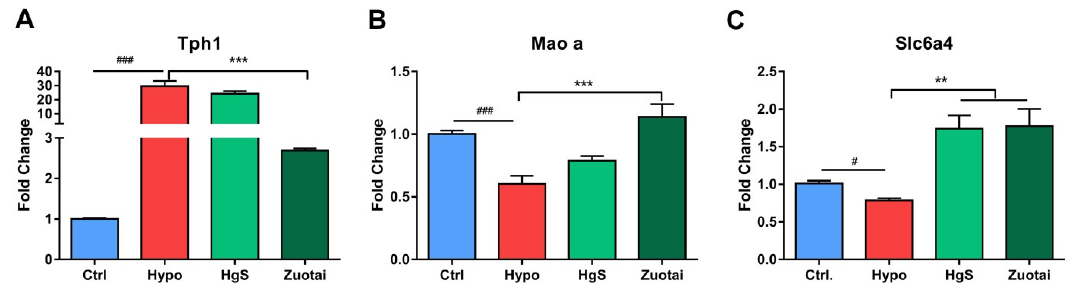
Table 1. Primers used for the detection of RIN-14B for RT-PCR reactions.